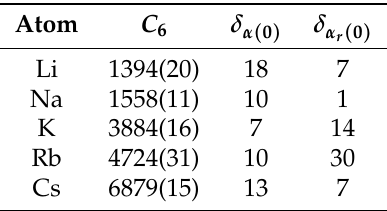
Table 4. Homonuclear van der Waals C 6 coefficients, in atomic units, calculated using experimental static polarizabilities shown in Table 1 and tabulated dynamic polarizabilities from [63]. The two contributions to the uncertainty δ α ( 0 ) and δ α for each C 6 value are, respectively, due to the r ( 0 ) uncertainties in measured α ( 0 ) and uncertainties estimated for Derevianko et al.’s values for α r ( i ω ) used to calculate α tab ( i ω ) . Derevianko et al. [33] reported uncertainty in α r ( 0 ) by using “an estimated 5% error for the core polarizabilities, and a 10% error for the remaining contributions to α r ( 0 ) ”. Several other authors also estimate 5% or 2% error for α core